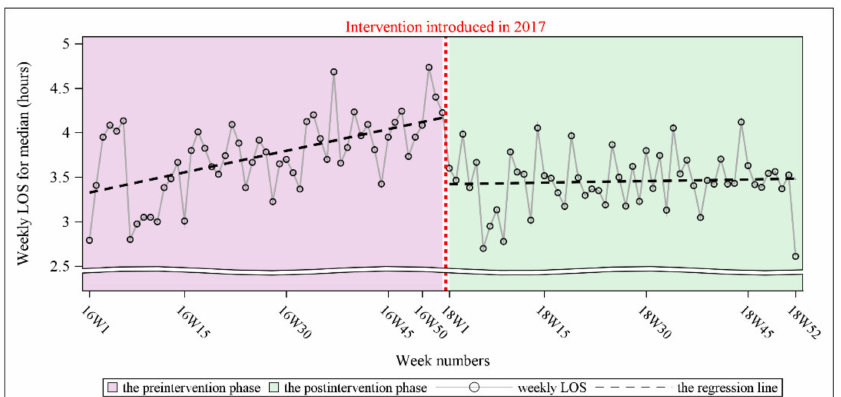
Figure 1. Comparison of weekly LOS for ED patient visits between the preintervention and postinter- vention phases with fitted segmented regression lines.